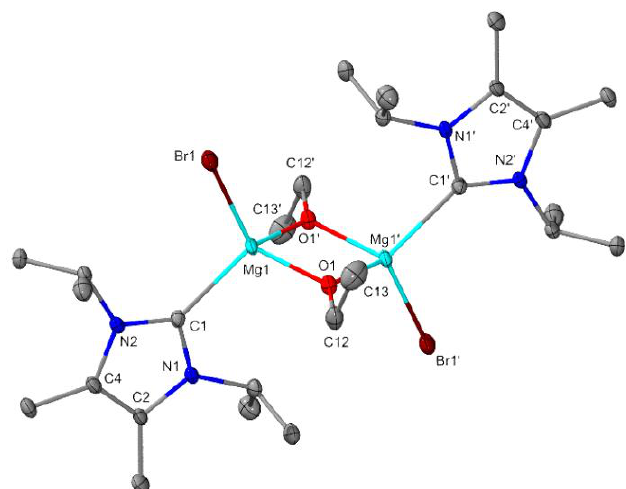
Figure 4. Molecular structure of 4 (thermal ellipsoids at 50% probability; H atoms omitted for clarity). Selected bond distances (Å) and angles (°): Mg1−O1: 1.9558(17); Mg1−O1: 1.9666(17); Mg1−C1: 2.236(2); N1−C1: 1.364(3); N2−C1: 1.357(3); Mg1−Br1: 2.4931(8); C2−C4: 1.346(3); N2−C4: 1.399(3); N1−C2: 1.404(2). C1−Mg1−Br1: 111.53(6); O1−Mg1−Br1: 116.30(5); O1’−Mg1−Br1: 113.13(5); O1−Mg1−O1’: 82.48(7); Mg1−O1−Mg1’: 97.52(7).